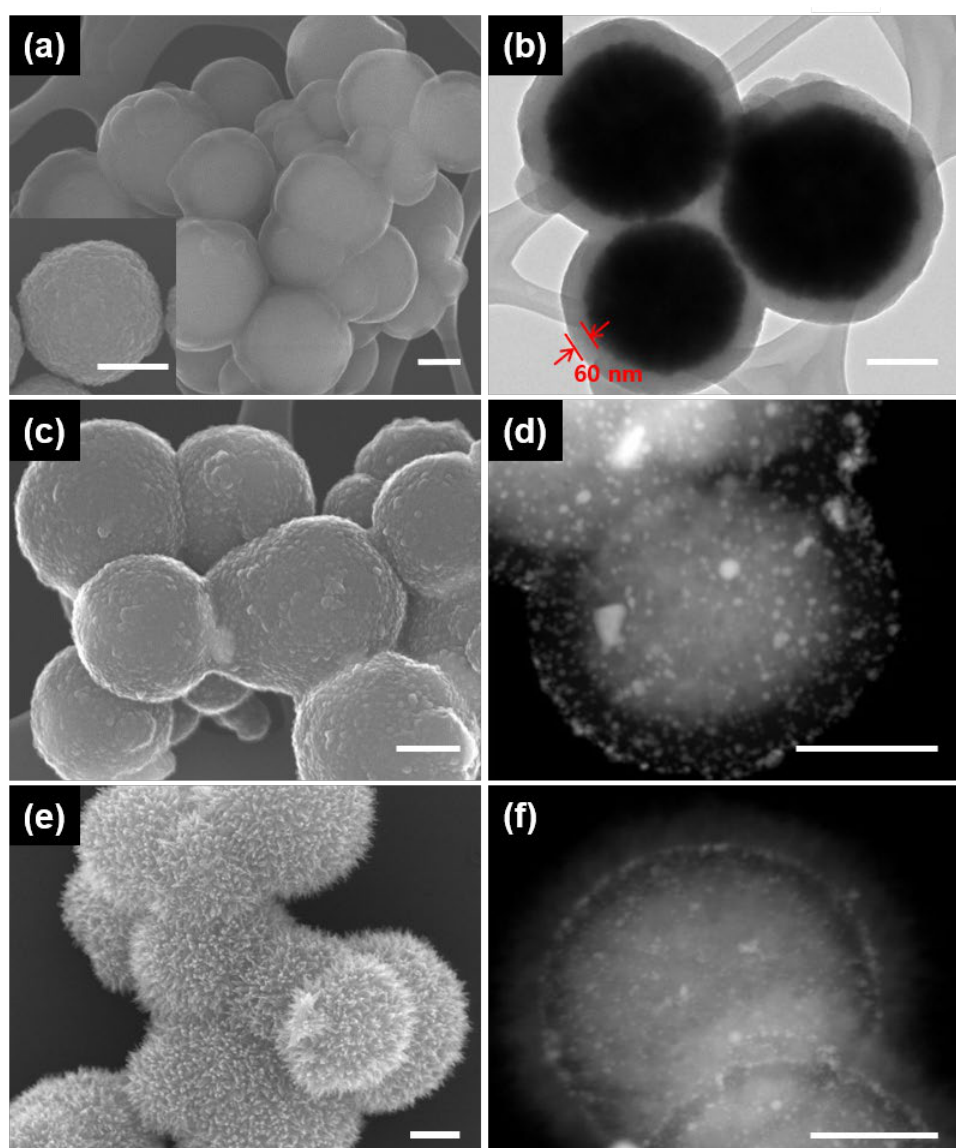
Figure 2. SEM and STEM images showing the formation of the magnetic hierarchical nanocomposites; ( a , b ) MNP@PD 60 ; ( c , d ) MNP@PD 60 /Au; and ( e , f ) MNP@PD 60 /Au/IO. Inset of ( a ) is an SEM image of the magnetic nanoparticles (MNPs). All scale bars represent 200 nm.